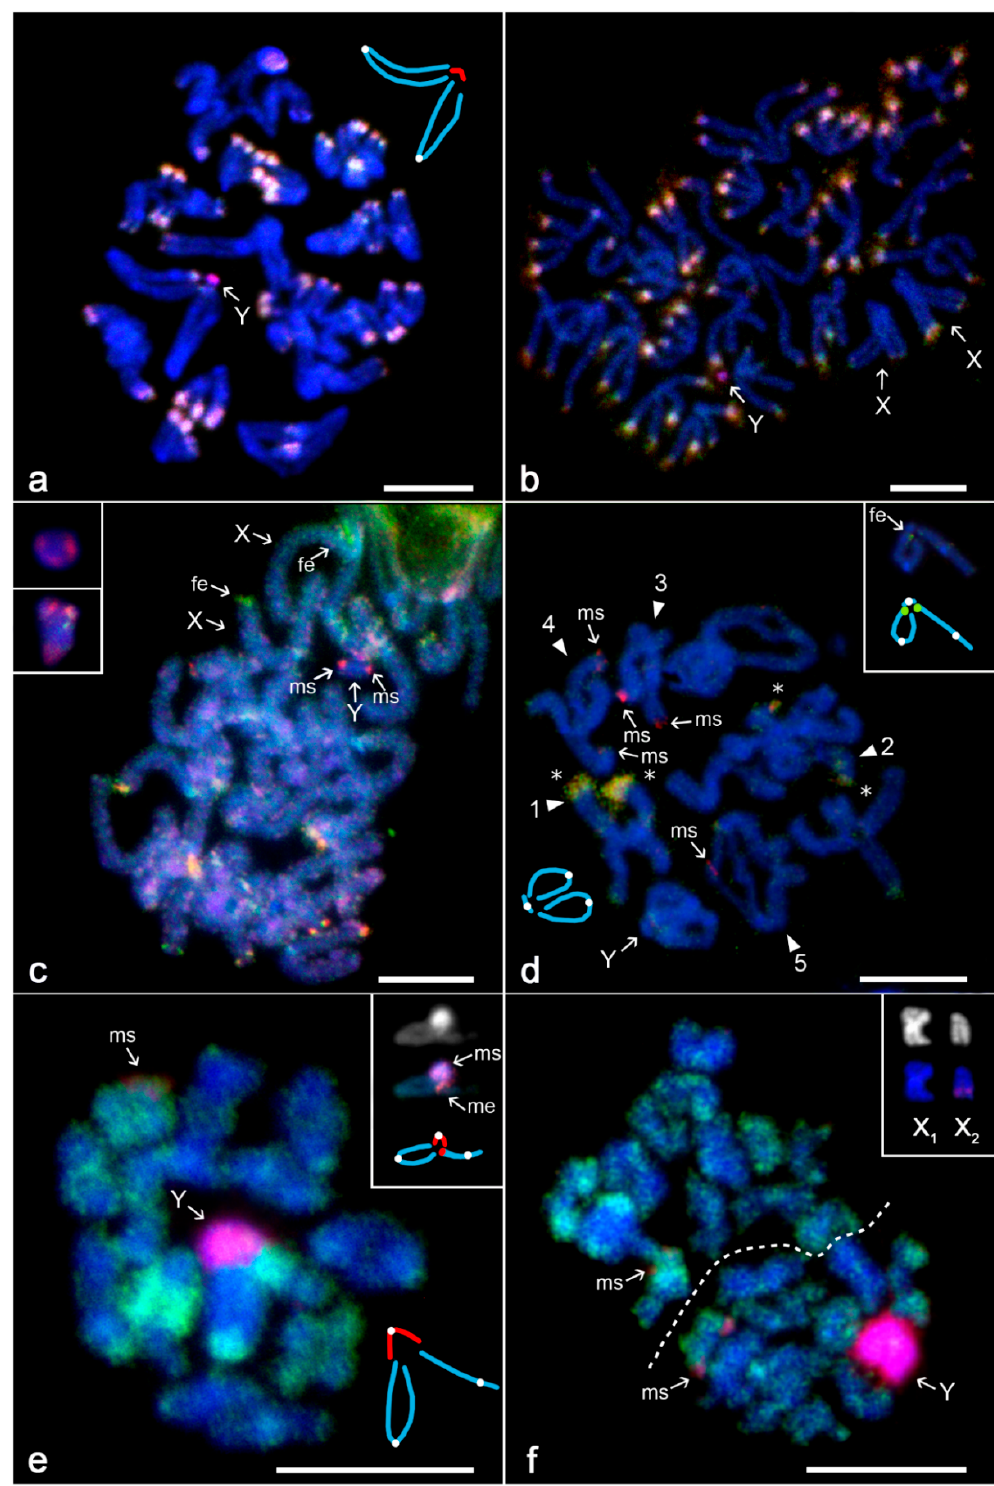
Figure 3. Comparative genomic hybridisation, haplogyne spiders with X 1 X 2 Y system, male plates. Abbreviations: fe—female enriched (i.e., biased accumulation of female probe; greenish), ms—male-specific signal (red), me—male enriched (i.e., biased accumulation of male probe; reddish).Figures a , d , e containschematicdrawingsofsexchromosomepairing(whitedots—centromeres, red dots—regions highlighted by the male probe). ( a , b ) Kukulcania a ff . hibernalis , Y chromosome labelled exclusively by male probe: ( a ) metaphase I; ( b ) fused sister metaphases II. In contrast to autosomes, sister chromatids of X chromosomes are not separated. Most chromosomes exhibit a